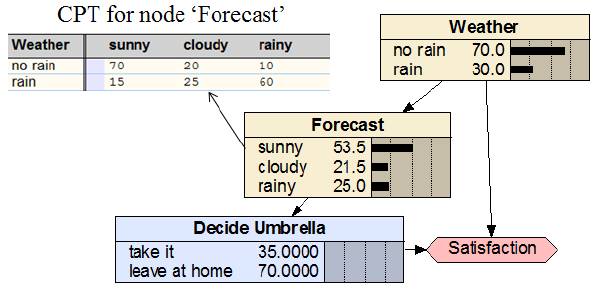
Fig. 2. A simple framework illustrating the structure and CPTs of the